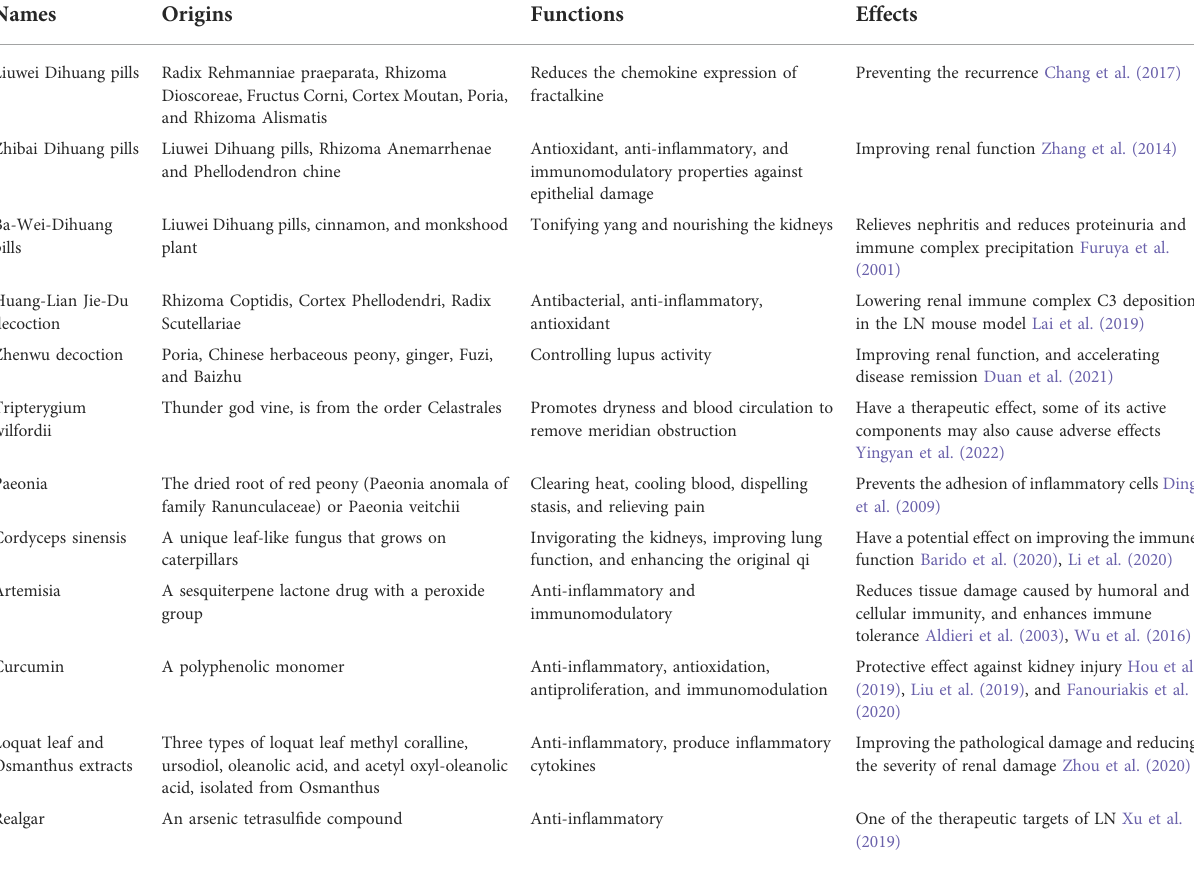
TABLE 1 Herbal traditional Chinese medicine for the treatment of lupus